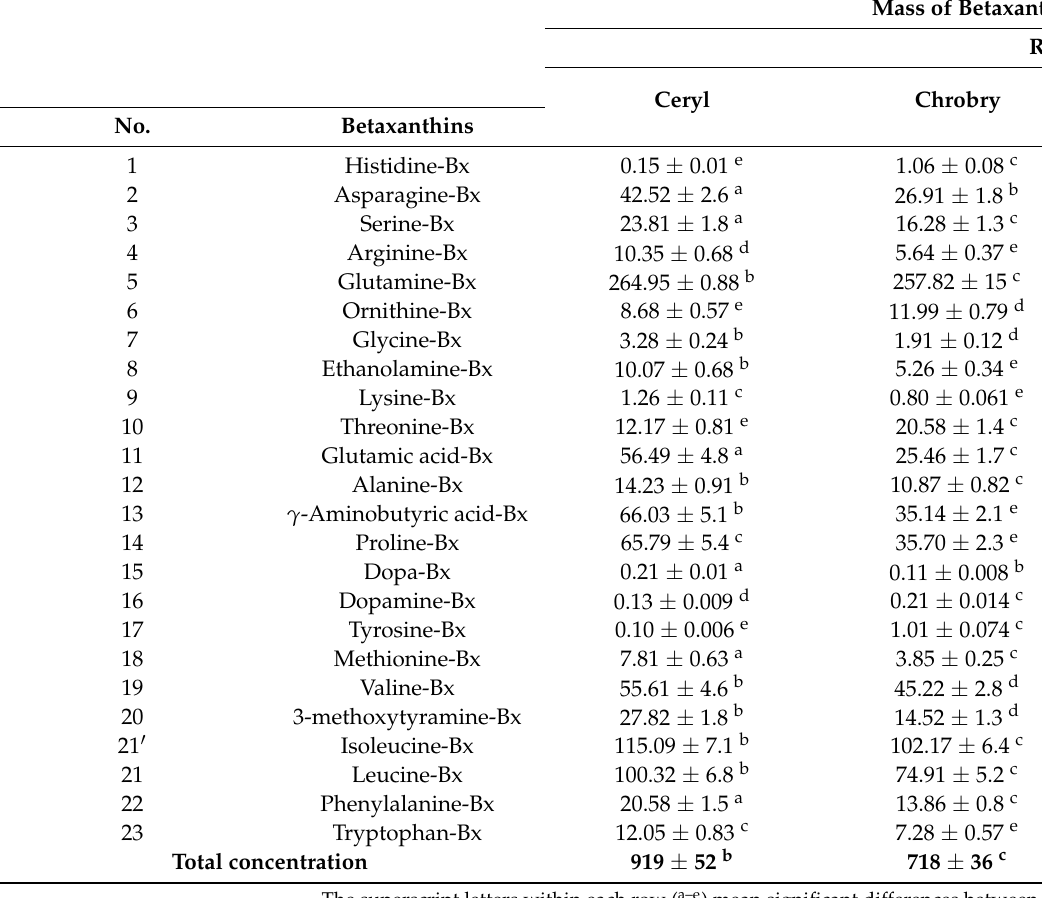
Table 2. Content of individual betaxanthins and total betaxanthins in the peel of red and yellow Beta vulgaris L. cultivars (mg/100 g of Dry Extract) analyzed by